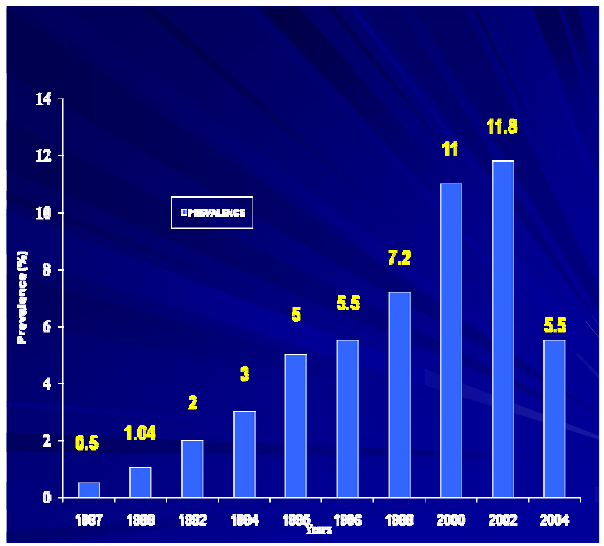
Figure 1: Evolution of HIV prevalence in